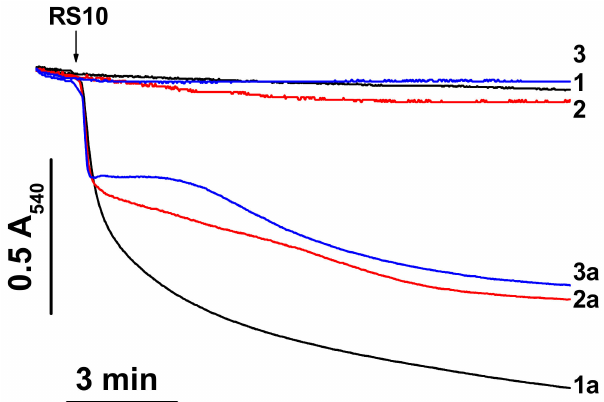
Figure 1. RS10 induces mitochondrial swelling in media of di ff erent ionic composition. Just before measurements, mitochondria (0.5 mg protein / mL) were added to sucrose-mannitol- (1, 1a), KCl- (2, 2a), and NaCl-based media (3, 3a) supplemented with 5 mM glutamate and 5 mM malate. The arrow indicates the addition of an RS10 extract (15 µ g / mL) (figures with index “a”). Representative data of one experiment of at least three similar are shown. The experiments were performed at 23 ◦